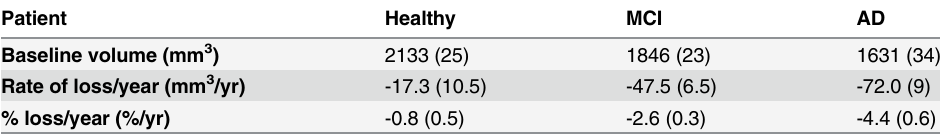
MCI, mild cognitive impairment; AD, Alzheimer ’ s disease. Volume loss was approximately 1% in